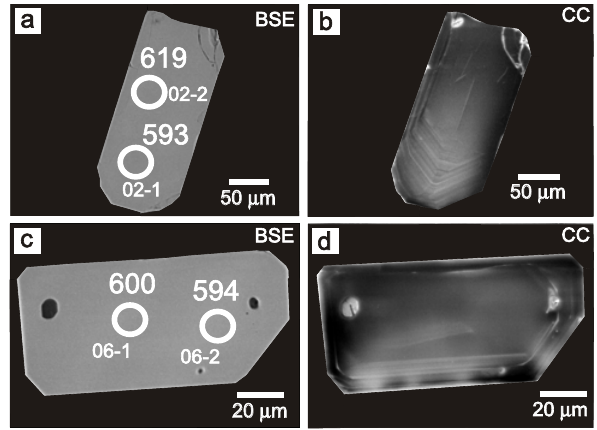
Fig. 4 – Backscattered electron (BSE) and charge contrast (CC) images of zircon grains from Sample 2. Circles indicate spot location; ages indicated in Ma. CC images were blackened with computer